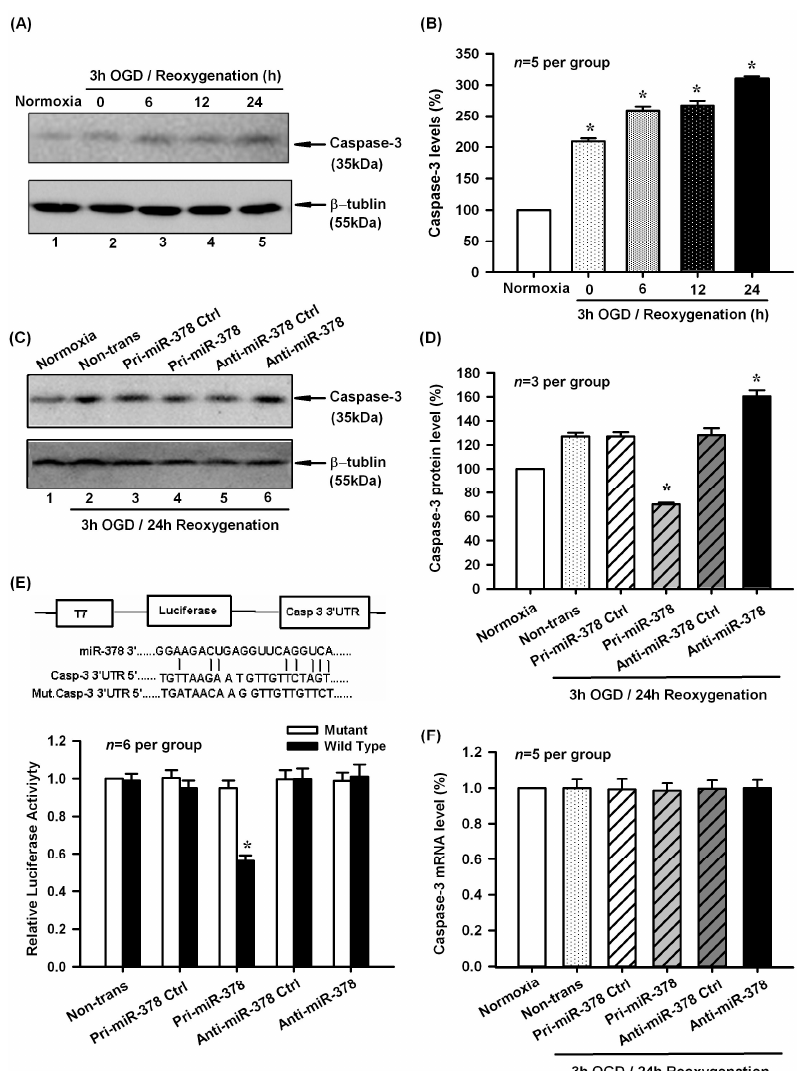
Figure 3. Effect of miR ‐ 378 on the mRNA and protein expression levels of its target gene Caspase-3 . ( A , B ) Representative Western blot and quantitative analysis showed the caspase ‐ 3 protein levels increased significantly in N2A cells at 0–24 h of reoxygenation after 3 h of OGD, * p < 0.05, n = 5 per group; ( C , D ) Transfection of pri ‐ miR ‐ 378 effectively decreased the expression of caspase ‐ 3, whereas anti ‐ miR ‐ 378 increased the expression of caspase ‐ 3 in mouse N2A cells exposed to 3 h OGD/24 h reoxygenation, * p < 0.05 vs. OGD non ‐ trans, n = 3 per group; ( E ) Upper panel, construction of luciferase reporter system; Lower panel, pri ‐ miR ‐ 378 decreased luciferase activity of the reporter vector containing 3 ′‐ UTR of caspase ‐ 3, but had no effect on the mutated reporter vector, * p < 0.05, n = 6 per group; ( F ) Pri ‐ miR ‐ 378 and anti ‐ miR ‐ 378 had no effect on Caspase-3 mRNA levels, n = 5 per group.